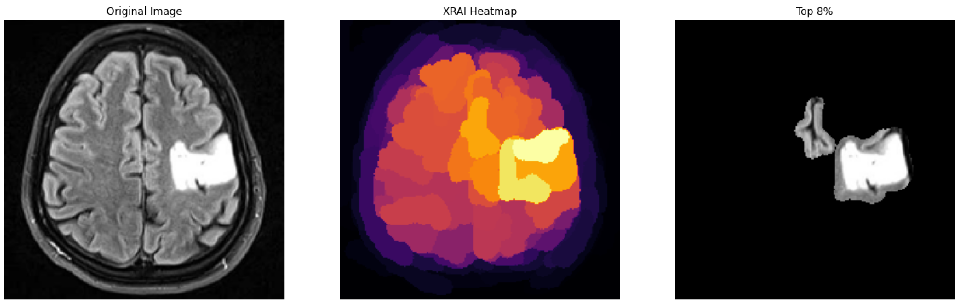
Figure 9. XRAI heatmap explanation for brain tumour detection and classification with the top 8% of the salient of the image.